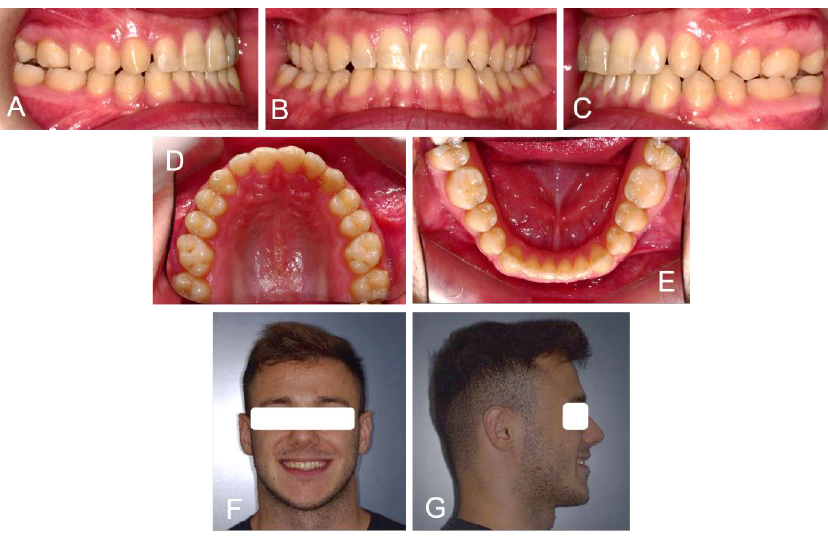
Figure 6. Intra and extra-oral pictures of the patient at the end of treatment: Right lateral occlusion ( A ); Frontal occlusion ( B ); Left lateral occlusion ( C ); Upper arch ( D ); Lower arch ( E ); Patients smile ( F ) and profile ( G ).